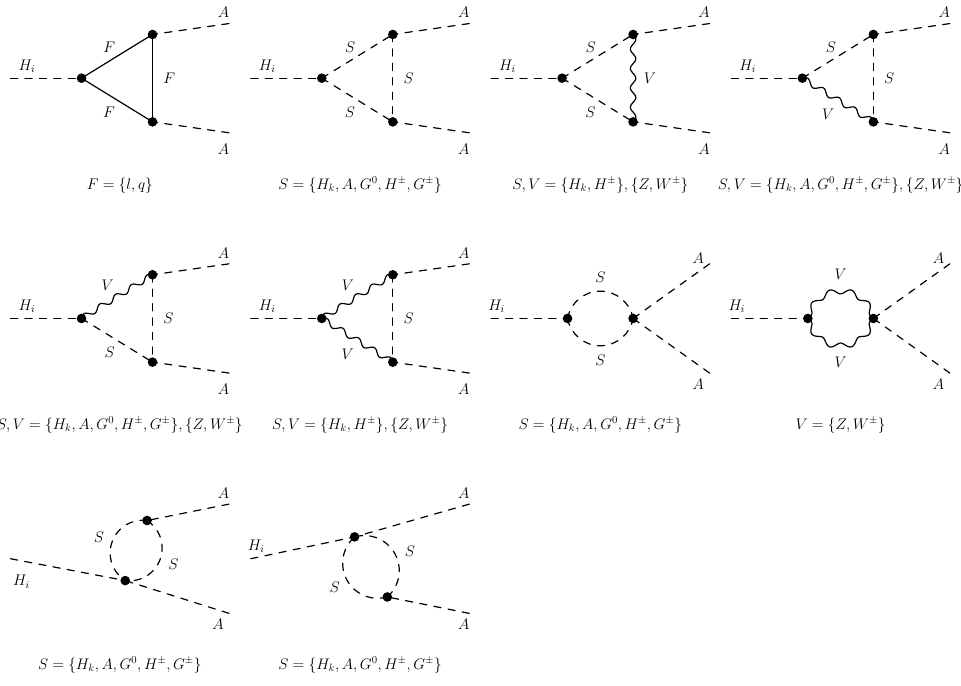
Figure 8 . Generic diagrams contributing to the vertex corrections in H i ! AA